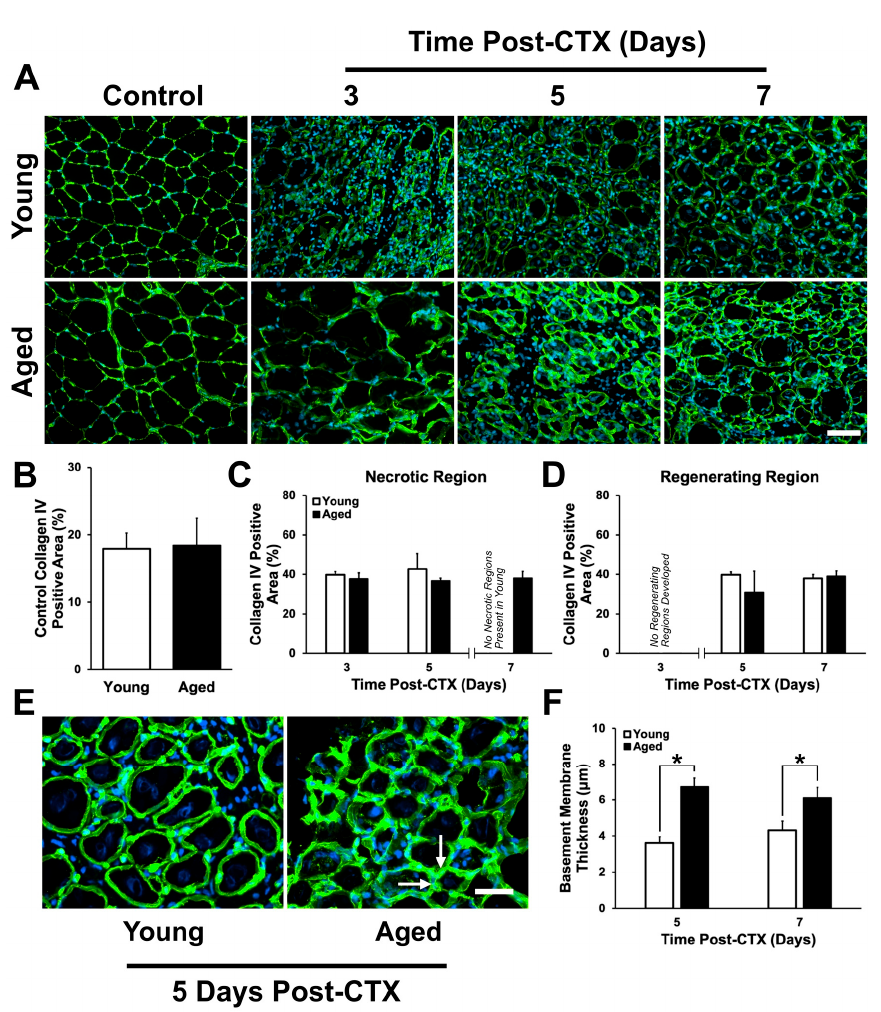
Figure 5. Collagen IV expression following cardiotoxin (CTX)-induced muscle damage in young and aged skeletal muscle. ( A ) Immunostaining of collagen IV (green) and DAPI (blue) at each time point following damage. ( B ) Collagen IV positive area in the undamaged contralateral leg was